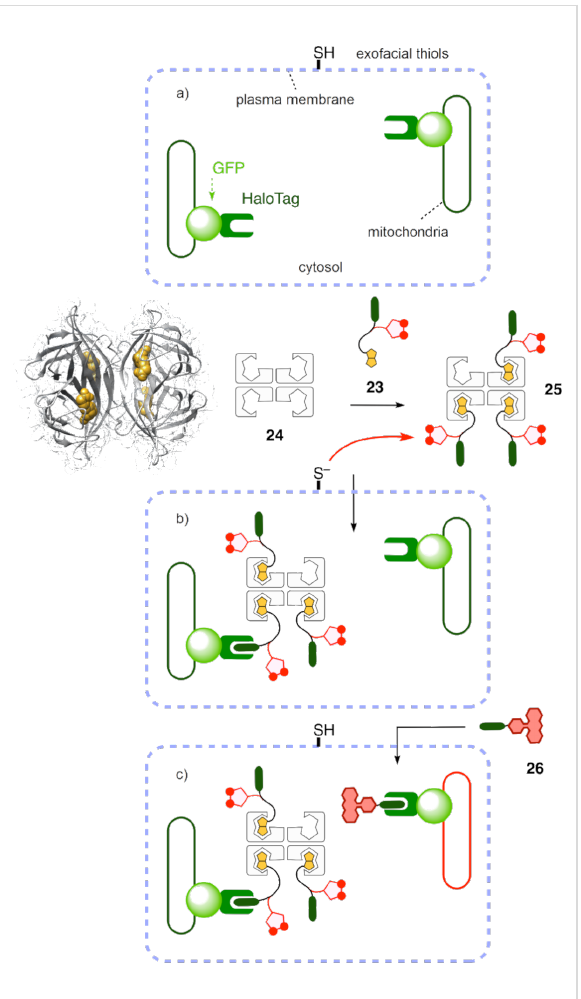
Figure 6: CAPA assay for the complex 25 , composed of three trans- porters 23 bound to one streptavidin 24 (with the structure of the homotetramer loaded with four biotins). Cytosolic delivery into HMG cells (a) has to precede the reaction of 25 with HaloTags on mitochon- dria (b). Afterwards, the unreacted HaloTags are labeled with the reporter 26 for quantification (c).